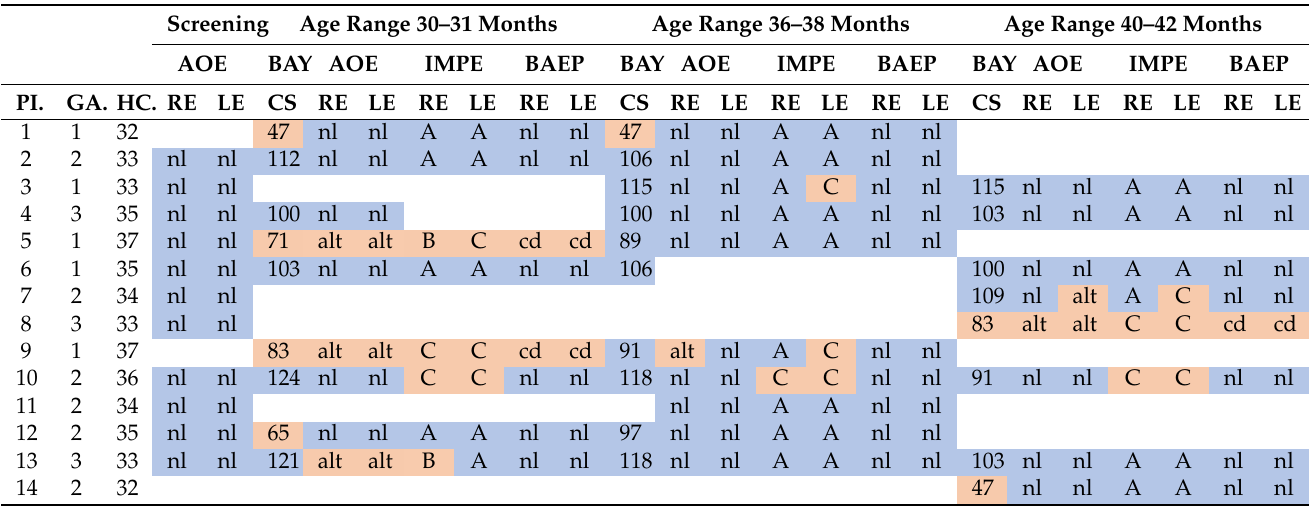
Table 2. Results by age